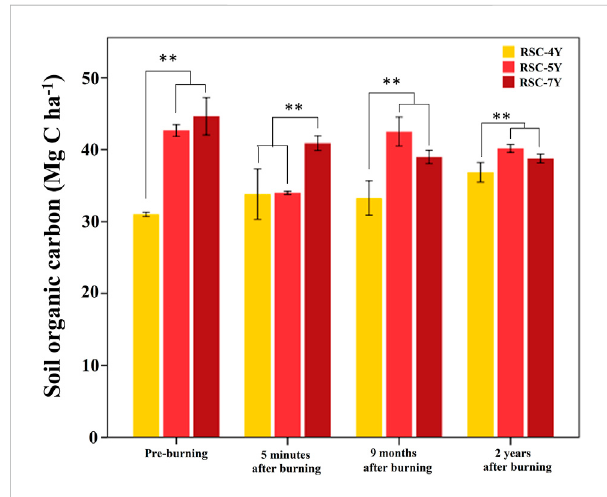
FIGURE 2 Soil organic carbon levels (Mg C ha − 1 ) in the topsoil (0 – 10 cm) before burning and at 5 min, 9 months, and 2 years after burning in three fallow fi